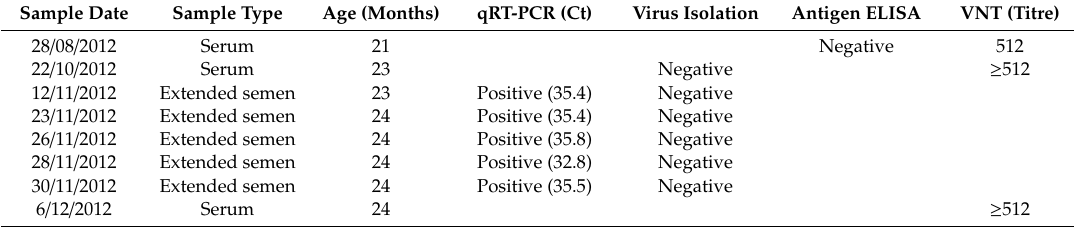
Table A1. Serological and virological test results for Bull 1.